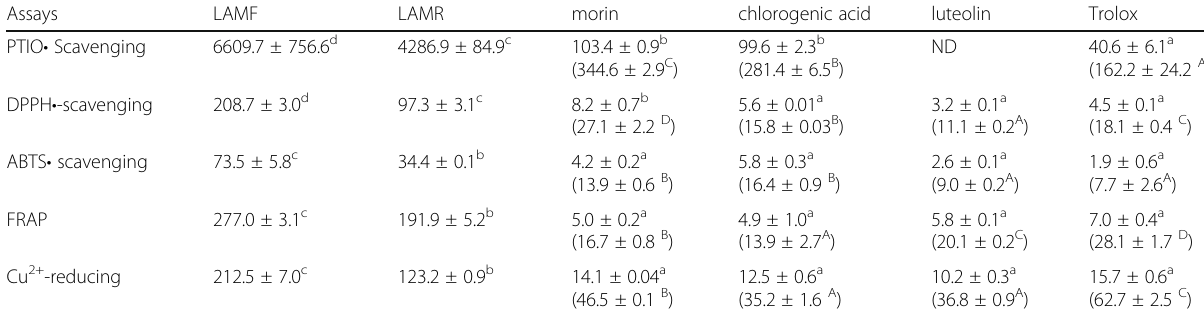
Table 1 The IC 50 values of LAMF, LAMR, morin, and chlorogenic acid in various antioxidant assays ( μ g/mL or μ M)